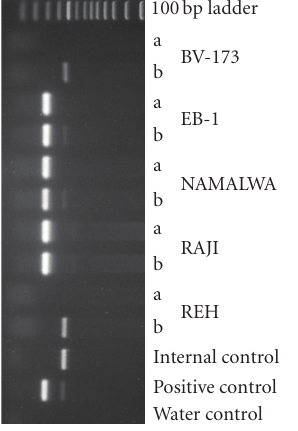
Figure 1: PCR analysis of EBV status in cell lines. Shown is an ethidium bromide-stained gel containing the reaction products following PCR amplification with the primers F-EBV and R-EBV (see Table 1). Products of 265bp were obtained. Shown are various examples of EBV-negative and EBV-positive cell lines. Two paired PCR reactions were performed: one PCR reaction contained an aliquot of the sample only (a) and the second reaction contained the sample under study plus the control DNA as internal standard, which results in an amplified product size of 445 bp (b). The cell cultures EB-1, NAMALWA, and RAJI are EBV-positive; the cell cultures BV-173 and REH, both B-cell precursor leukemia cell lines, are